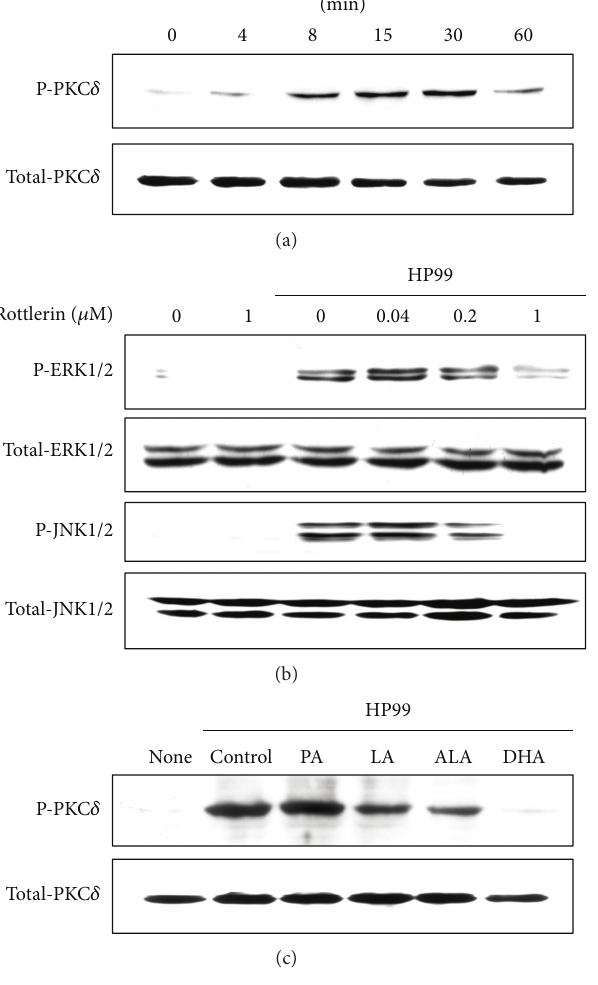
Figure 6: Effects of PUFAs on PKC 𝛿 activation in H. pylori - stimulated AGS cells. (a) AGS cells were infected with H. pylori for the indicated time points (4, 8, 15, 30, and 60 min). Phosphospecific and total forms of PKC 𝛿 were determined by western blotting. (b) AGS cells were pretreated with various concentrations of rottlerin (0.04, 0.2, and 1 𝜇 M), a specific PKC 𝛿 inhibitor, for 1h and then cultured with H. pylori for 30 min. Phosphospecific and total forms of ERK and JNK in whole cell extracts were determined by western blotting. (c) AGS cells were pretreated with individual fatty acid (100 𝜇 M) for 24 h and were then cultured with H. pylori for 8min.